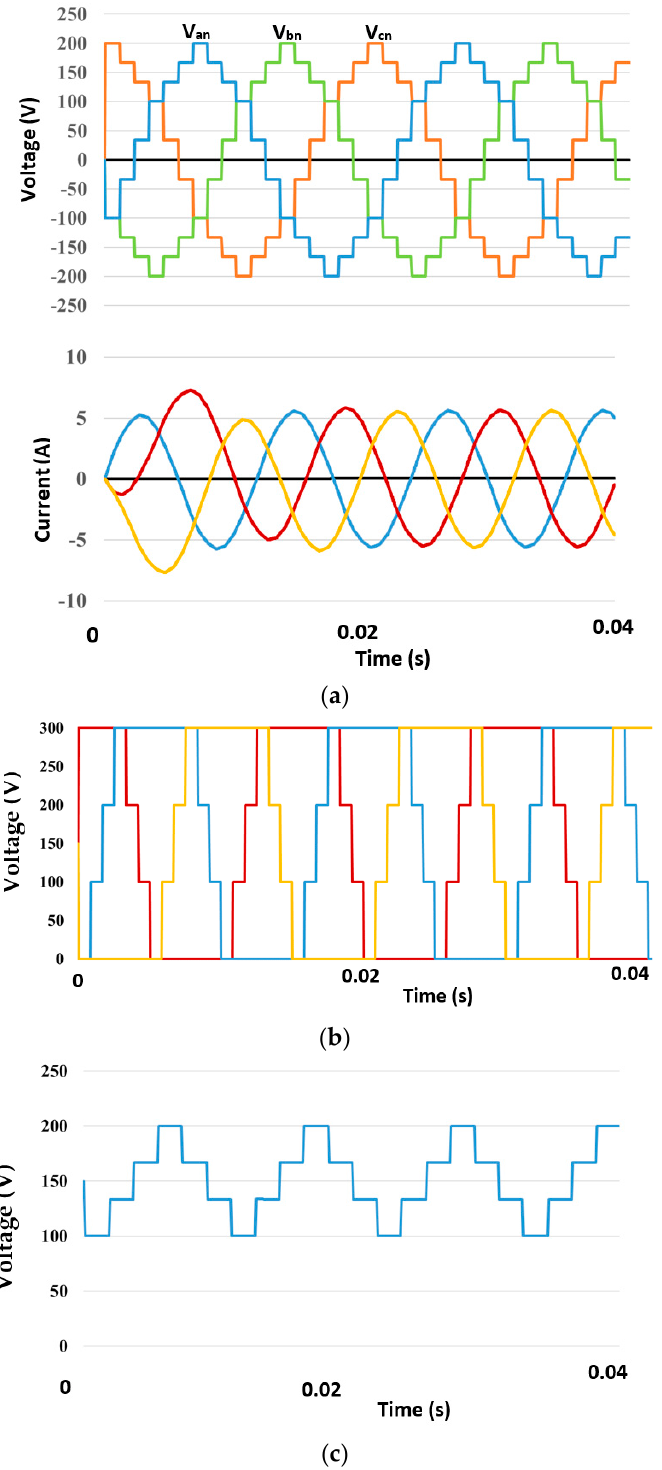
Figure 7. Simulation results for 4LT 2 C ( a ) line-to-neutral voltages & load current, ( b ) line-to-ground voltages ( c ), and neutral to ground voltage.